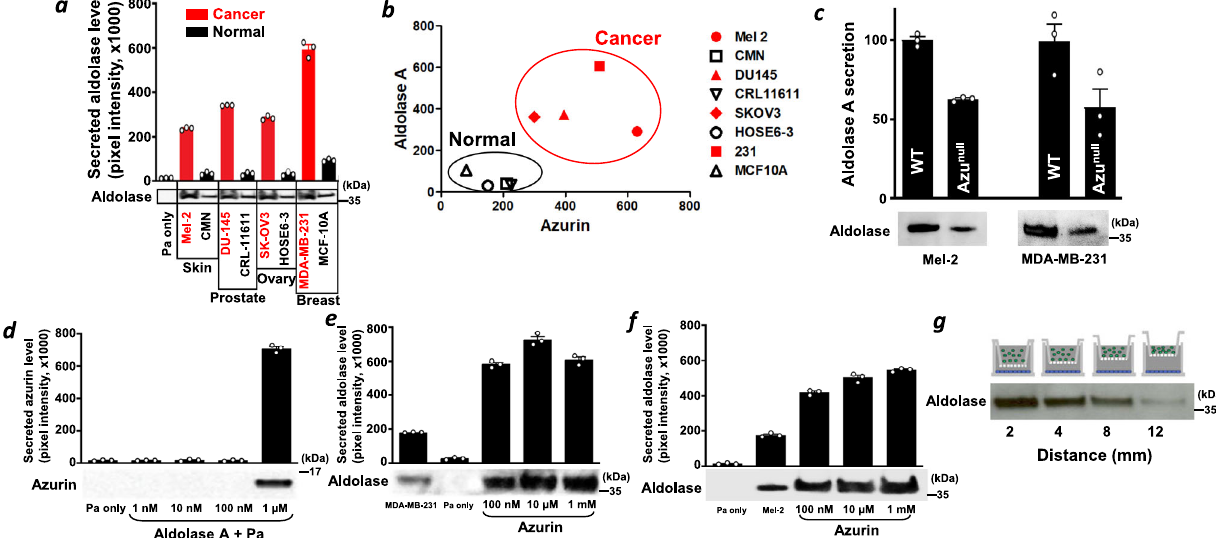
Fig. 2 A bidirectional interaction between P. aeruginosa and human cancer cells. a Induction of aldolase A secretion by host cells in the presence of P. aeruginosa . Human host cells (cancer and normal) and P. aeruginosa were co-incubated for 30 min at a concentration of 500,000 human cells/ml with P. aeruginosa at OD = 0.3. Aldolase secretion varied between the co-cultures with cancer and normal cells. Secretion of azurin and aldolase into the culture supernatant was assessed by western blot analysis; the graph shows the observed band intensities. b Correlation between the aldolase A and azurin levels in co-cultures of P. aeruginosa with cancer or normal cells. c Cancer cells (Mel-2 and MDA-MB-231) and P. aeruginosa (WT and azu null mutant) were co- incubated for 30 min at a concentration of 500,000 human cells/ml with P. aeruginosa at OD = 0.3. Secretion of aldolase into the culture supernatant was assessed by western blot analysis. d P. aeruginosa (OD = 0.3) was treated with puri fi ed aldolase A protein at concentrations of 1 nM, 10 nM, 100 nM, and 1 μ M for 30 min. Treatment with 1 μ M aldolase A stimulated azurin secretion from P. aeruginosa , suggesting that aldolase A is a stimulatory factor for azurin secretion. Secretion of azurin by P. aeruginosa into the culture supernatant was assessed by western blot analysis; the graph shows the observed band intensities. MDA-MB-231 ( e ) and Mel-2 ( f ) cells were treated with puri fi ed azurin protein at concentrations of 100 nM, 10 μ M, and 1 mM for 30 min. Secretion of aldolase A by cancer cells into the culture supernatant was assessed by western blot analysis; the graph shows the observed band intensities. P. aeruginosa (Pa only) did not show any signal as it did not secret any proteins that cross-react with anti-aldolase A antibody. g Aldolase A secretion in the presence of P. aeruginosa is distance-dependent. Mel-2 cells and P. aeruginosa were separated with a permeable Transwell ® insert. In this co-culture system, P. aeruginosa (OD = 0.3) and Mel-2 cells (3,000,000 cells/ml) were separated at distances ranging from 0 mm to 12 mm and incubated for 30 min at 37 °C. Aldolase A secretion decreased as the distance between the two cell populations increased. Secretion of aldolase by Mel-2 cells into the culture supernatant was assessed by western blot analysis; the graph shows the observed band